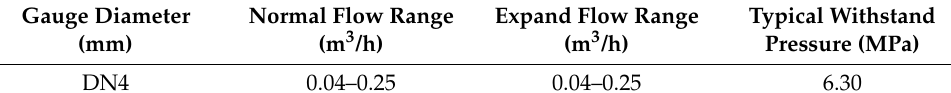
Table 2. Parameters of the DN4 Micro Flowmeter.